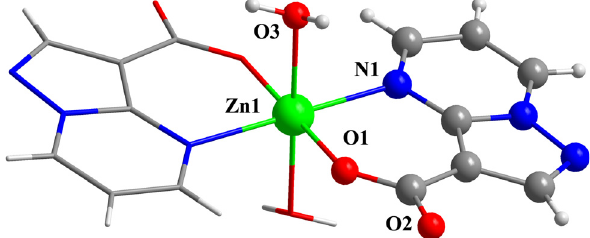
Table  : Data collection and